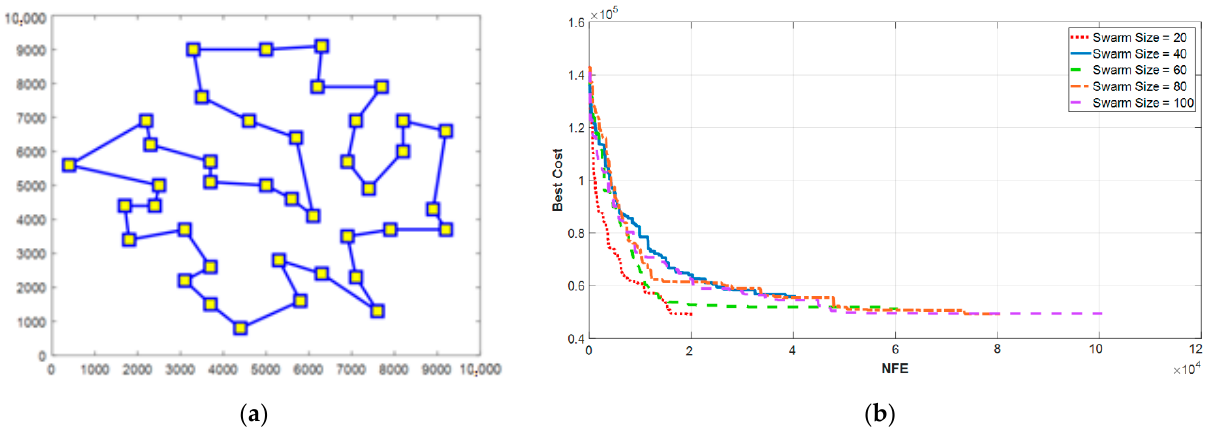
Figure 20. ( a ) The optimal flight path calculated by the enhanced PSO algorithm and ( b ) the performance of the EPSO